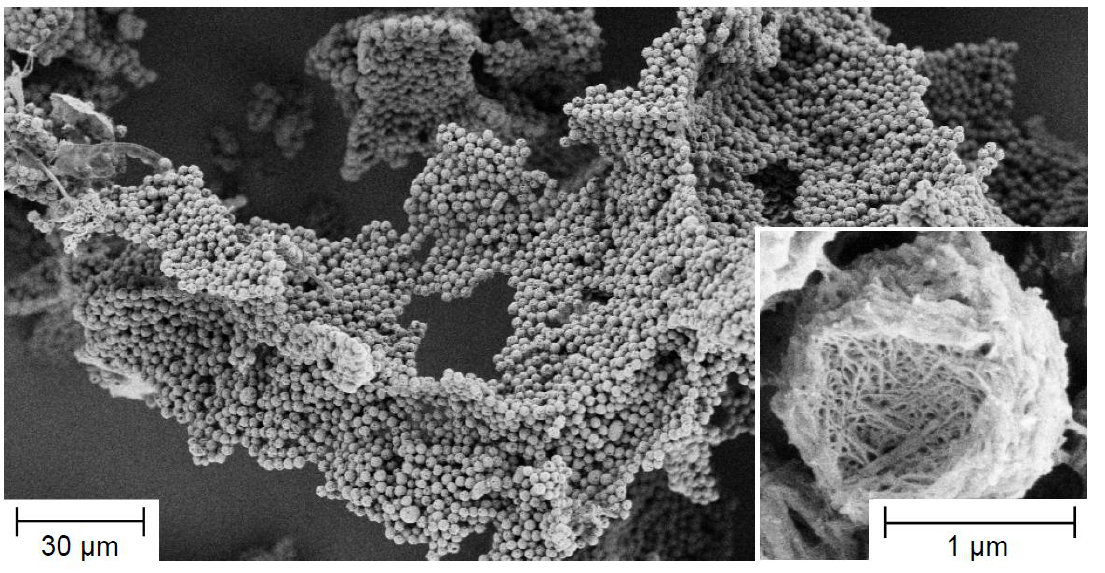
Figure 8. Scanning electron micrographs of crystalline PiPrOx microparticles with hierarchical structure, coagulated out of hot water and freeze-dried [11], reproduced by permission of